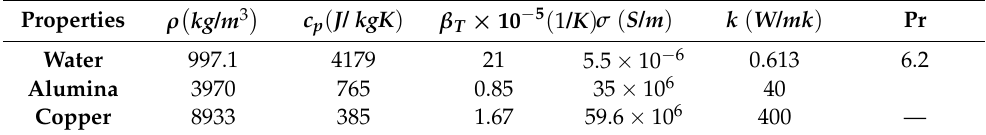
Table 1. The thermophysical properties of the hybrid